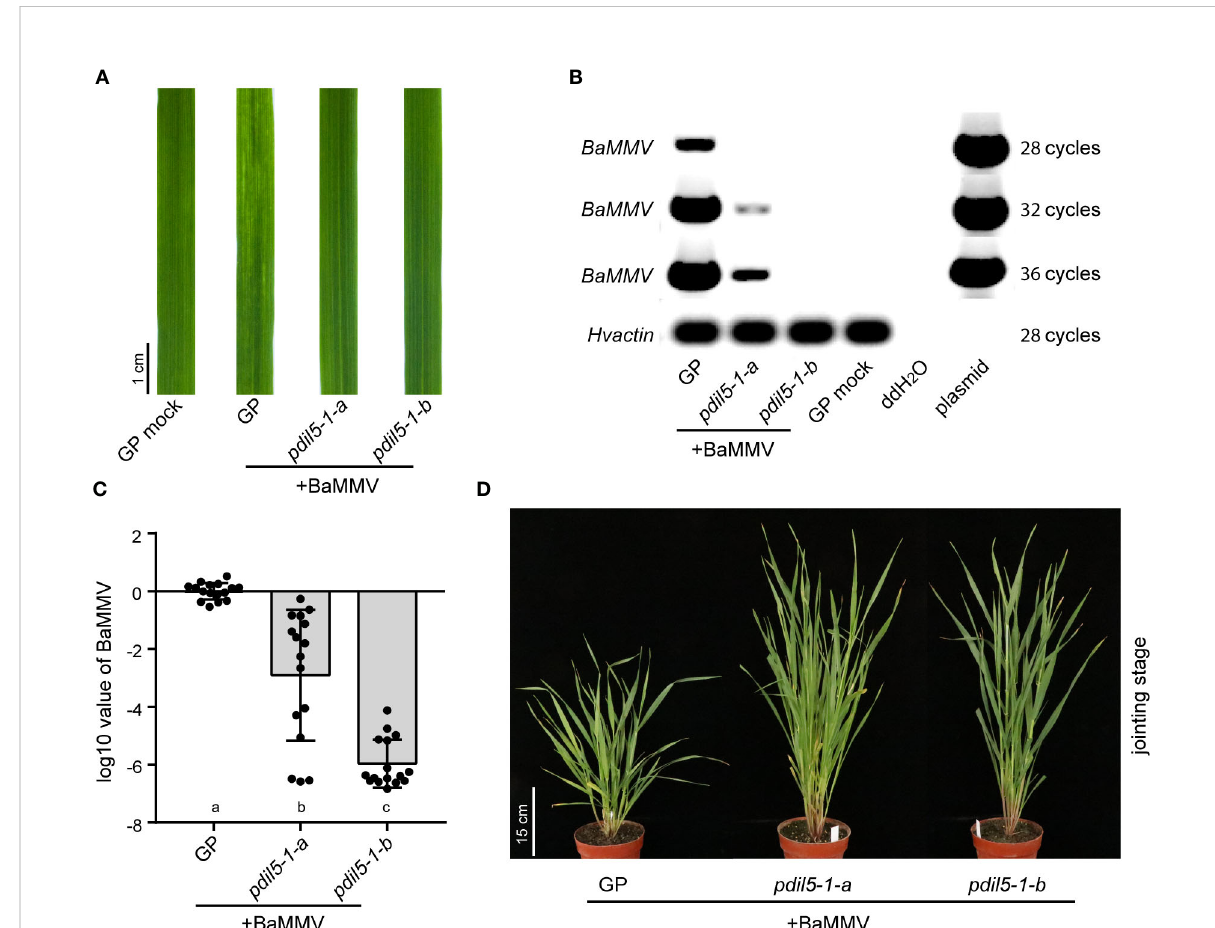
FIGURE 2 Editing of HvPDIL5-1 improves BaMMV resistance. (A) Phenotypes of the pdil5-1 mutants and wild type (GP, Golden Promise) at 6 weeks post BaMMV inoculation. GP mock, Golden Promise inoculated with buffer only. RT-PCR (B) and qRT-PCR (C) detection of BaMMV accumulation. The barley actin gene was used as the endogenous control. In (C) , black dots represent individual assays ( n = 16). Statistical tests were conducted using Tukey ’ s post hoc analysis of variance (ANOVA) ( p = 0.05); different letters below bars indicate statistically signi fi cant differences. Error bars represent standard deviation (SD). (D) Phenotypes of BaMMV-inoculated PDIL5-1- edited mutant lines at the jointing stage under normal greenhouse